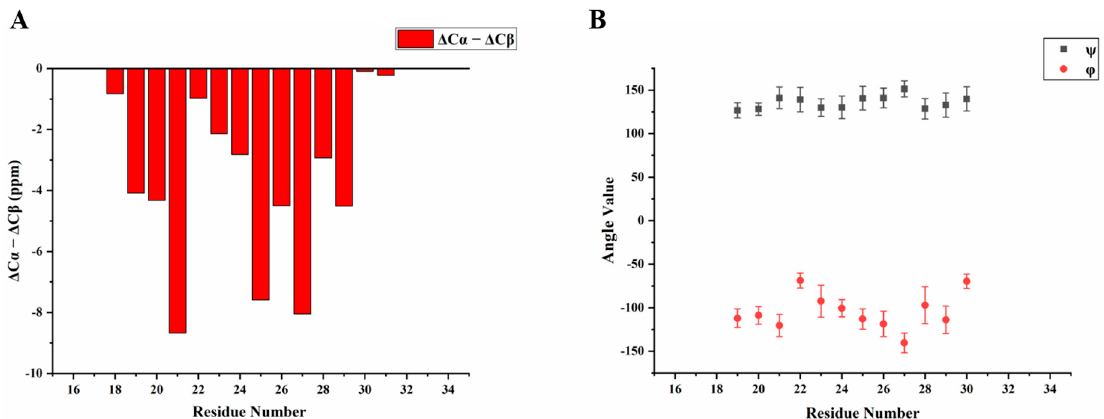
Figure 7. Secondary structure prediction based on the chemical shifts assignment of H175 self-assembly at pH 6.0. The sequence of H175 is displayed on the top, highlighting the sequentially assigned sequence in red ( 18 E - 31 P). ( A ) The calculated secondary chemical shifts ( ∆ C α - ∆ C β ) show the negative values for the identified sequence. ( B ) Predicted protein dihedral angles ψ and ϕ using TALOS-N, indicating β -sheet secondary